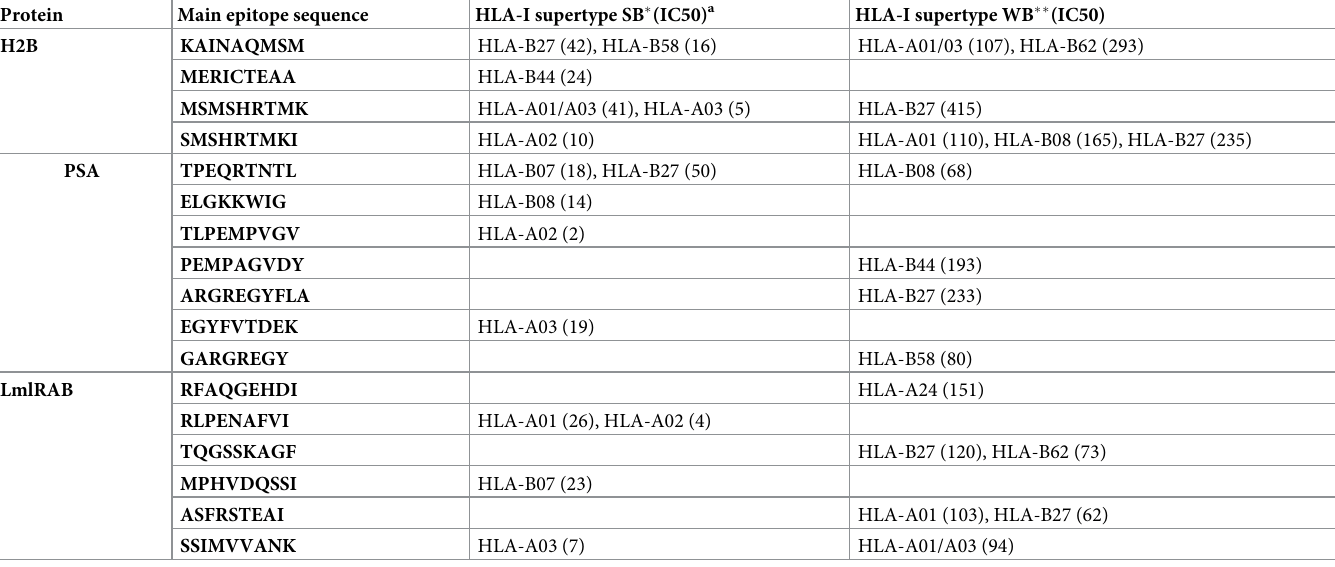
Table 3. Characteristics of in silico predicted HLA-I restricted epitopes derived from H2B, PSA and LmlRAB proteins. Protein